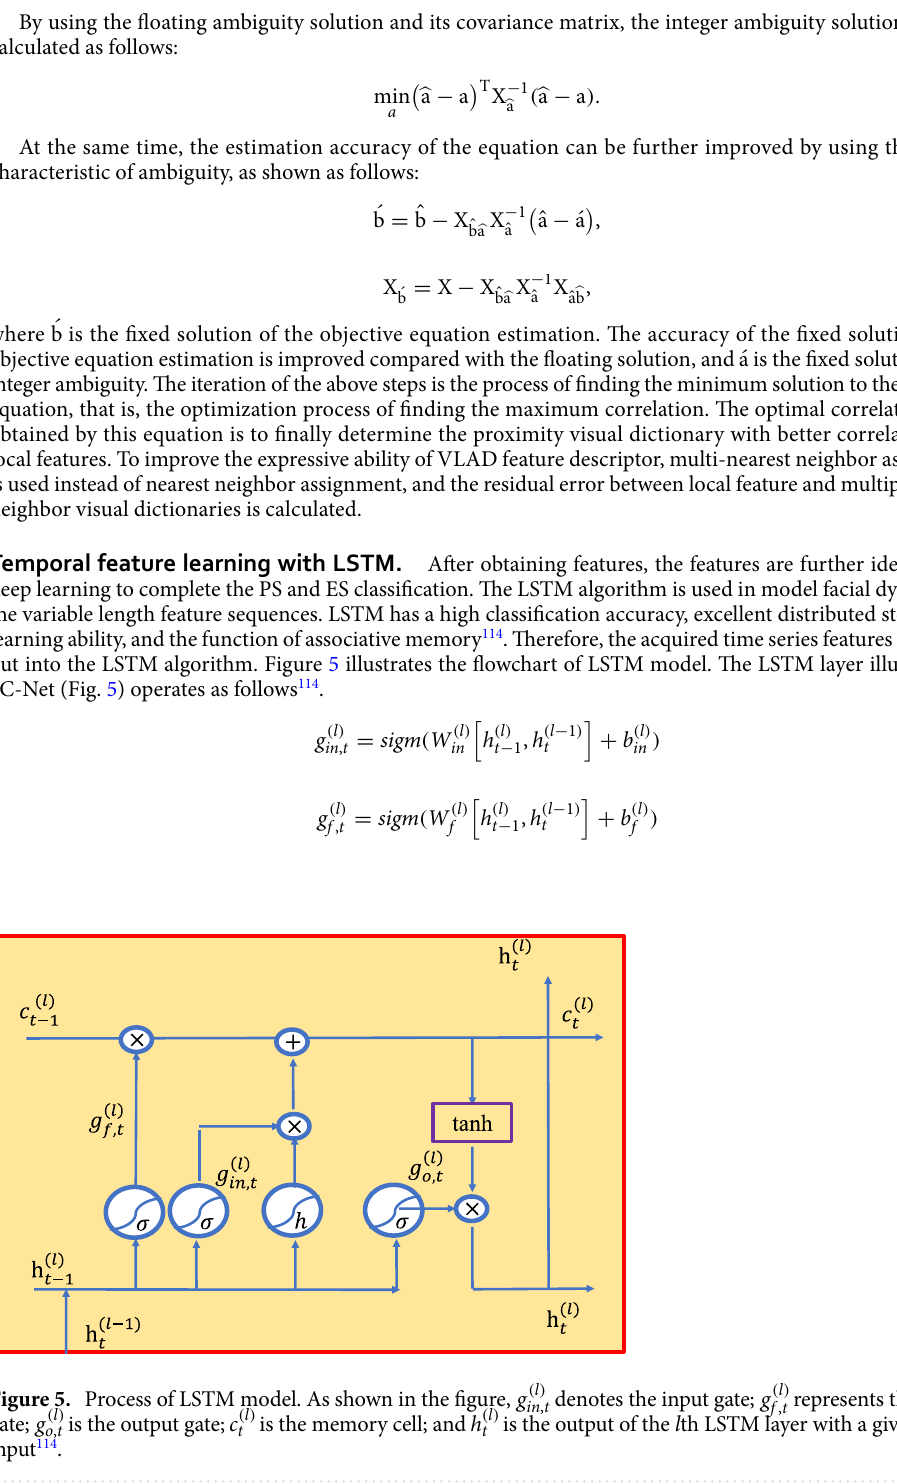
Figure 5. Process of LSTM model. As shown in the figure, g ( l ) gate; g o , t is the output gate; c input 114